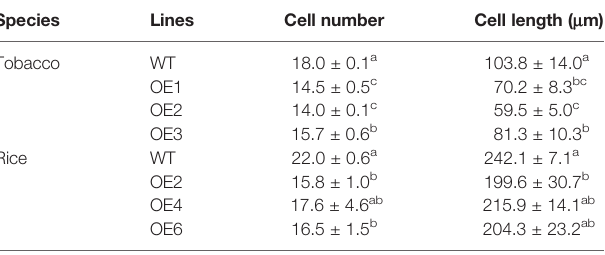
TABLE 4 | Measurement of cell length and cell number of wild-type and ZmMYB59 transgenic plants Species Lines